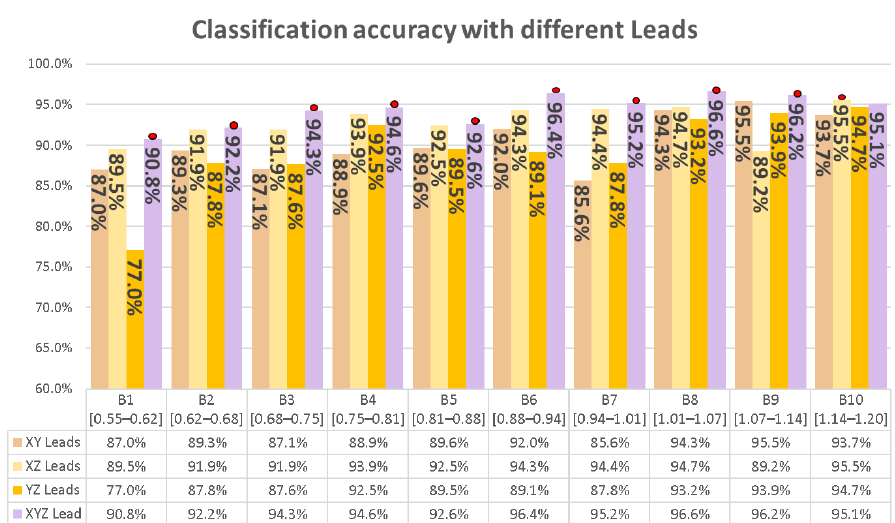
Figure 9. Combined leads accuracy results. ( • means maximum value per set).